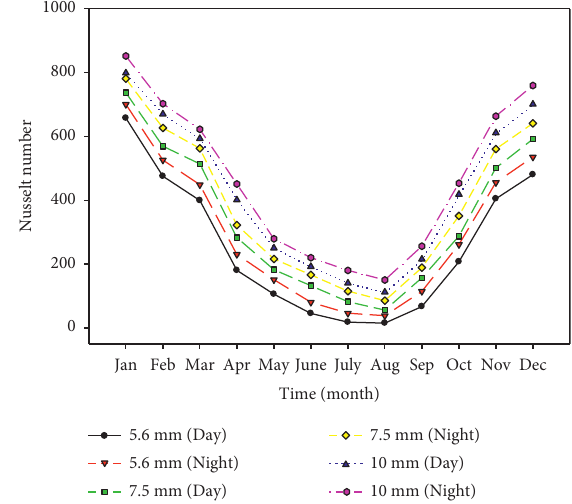
Figure 13: Effect of water depth on Nusselt number for reactor inclined at 1 ° , Re � 9000 and aspect ratio � 180.